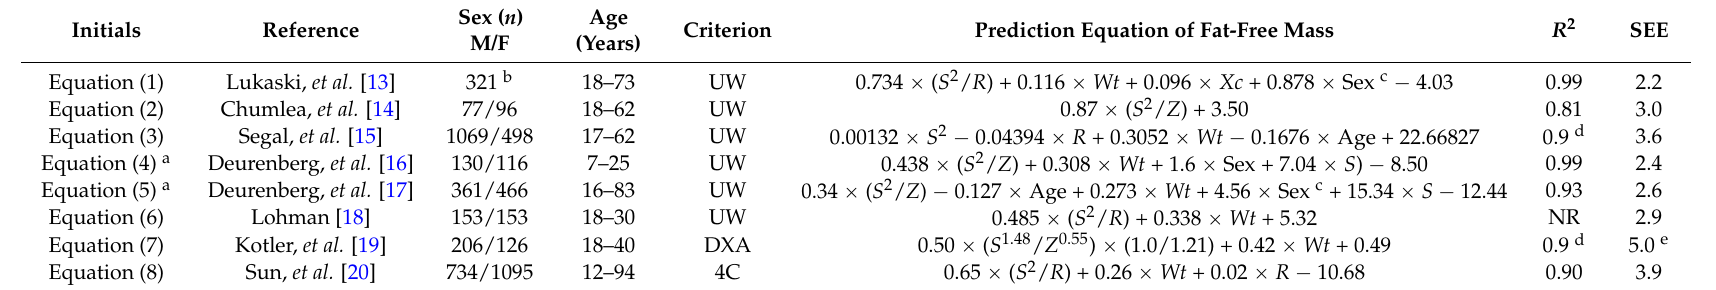
Table 1. Characteristics of predictive equations of BIA selected for the estimation of